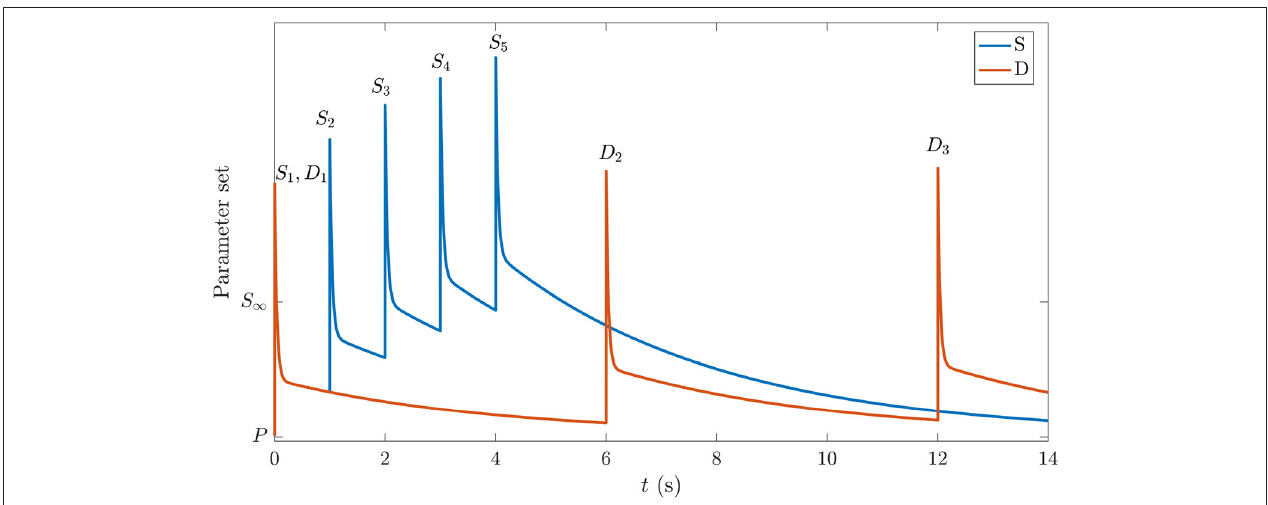
FIGURE 3 | Schematic of gain responses of the pre-stimulation (P) state and the trajectories followed by the different parts of the corticothalamic system that process the S and D stimuli. The vertical axis schematically represents the response of the set of system gains, with starting point P and the asymptotic value in the S curve corresponds to D 1 , ... , D 3 .